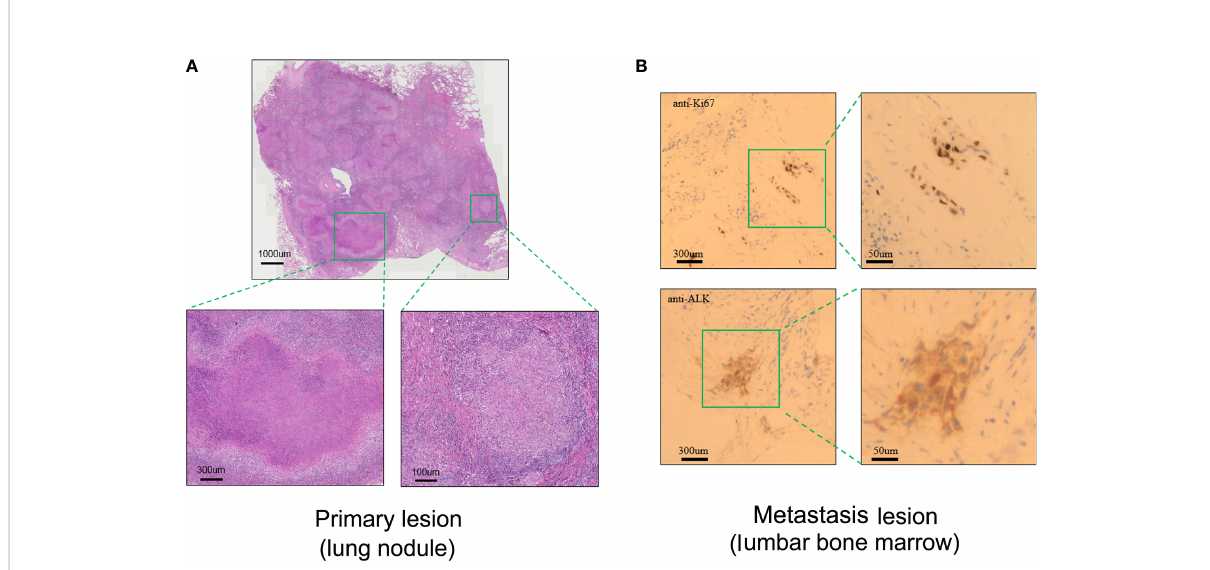
FIGURE 2 Pathological assessment of the primary lung lesion and metastasis lesion after radiotherapy. (A) Representative biopsy scan of primary lung lesion by HE (hematoxylin and eosin) staining. (B) Representative biopsy scan of lumbar bone marrow with Ki67 and ALK antibody by IHC (immunohistochemistry)